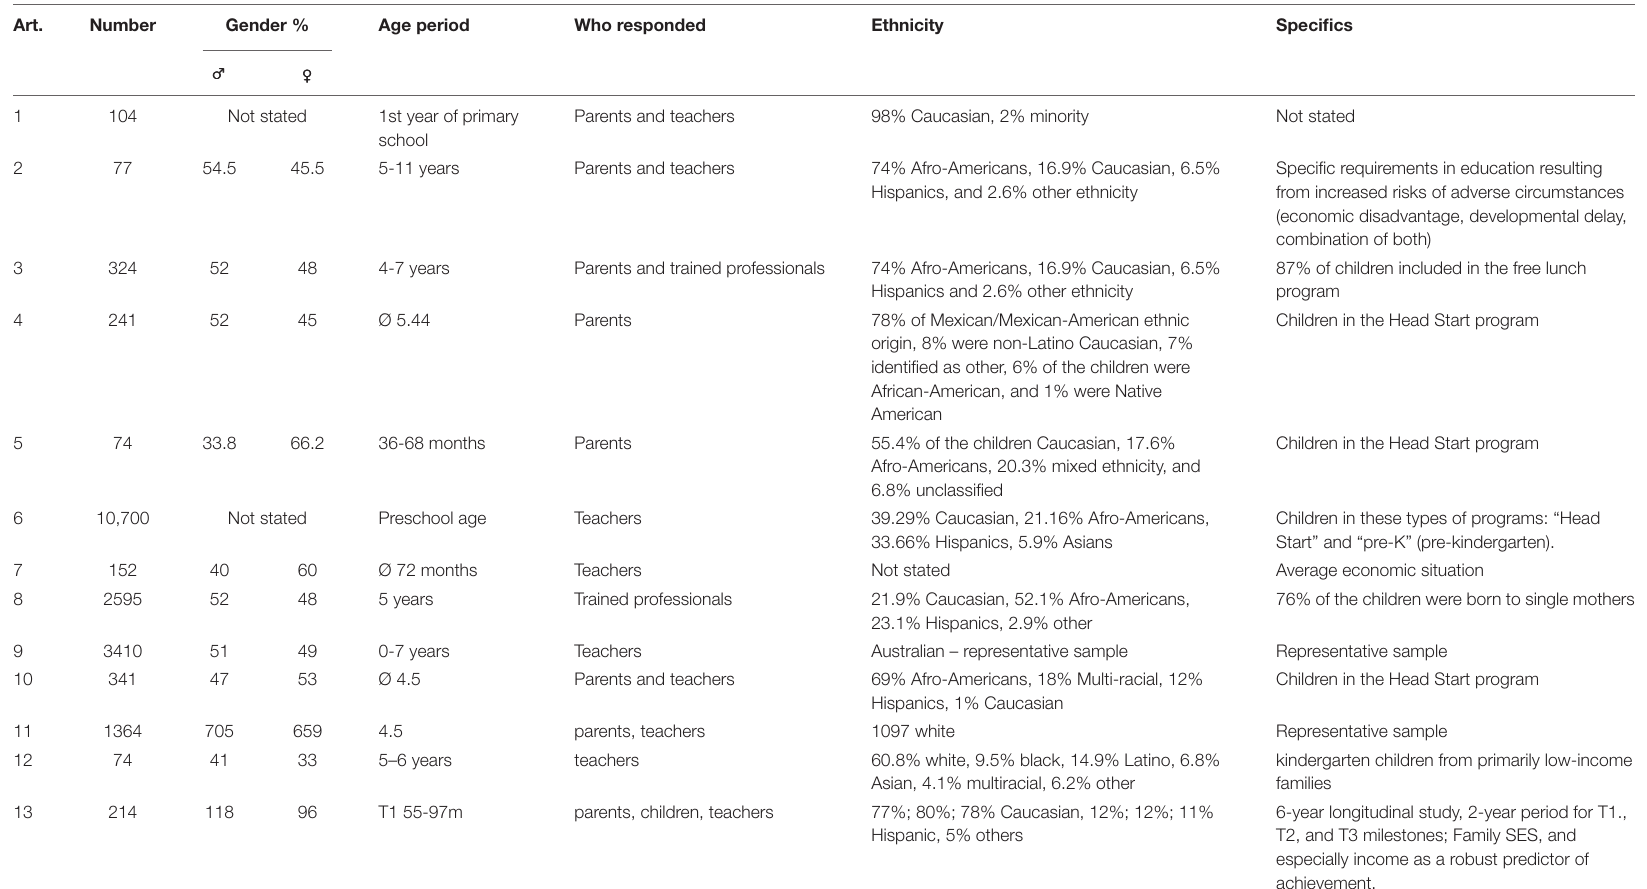
TABLE 2 | Qualitative indicator – target group.